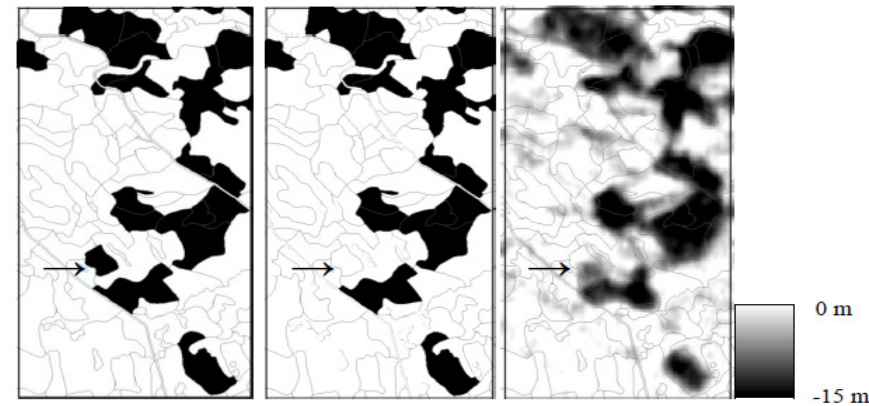
Figure 1. Changes from Shuttle Radar Topography Mission (SRTM)-X to Tandem-X over a 1 km × 2 km part of the study area. One stand with partial logging is indicated with an arrow. ( Left ) Clear-cut stands as recorded by the forest owner. ( Middle ) Stands classified as clear-cut based on a mean InSAR Digital Surface Models (DSM) decrease < − 7 m. ( Right ) Changes in InSAR DSM in a 10 m × 10 m raster. Only negative changes are